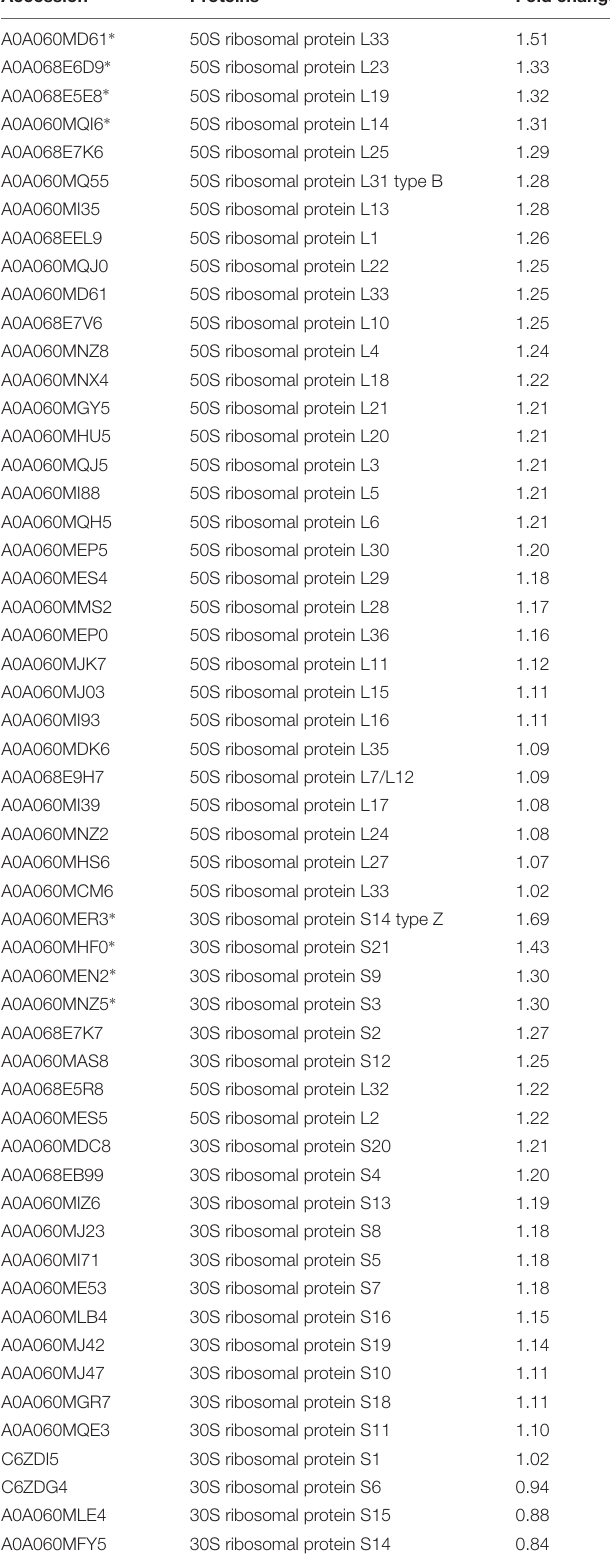
TABLE 3 | Changes in the ribosomal protein expression after azithromycin treatment. Accession Proteins Fold change